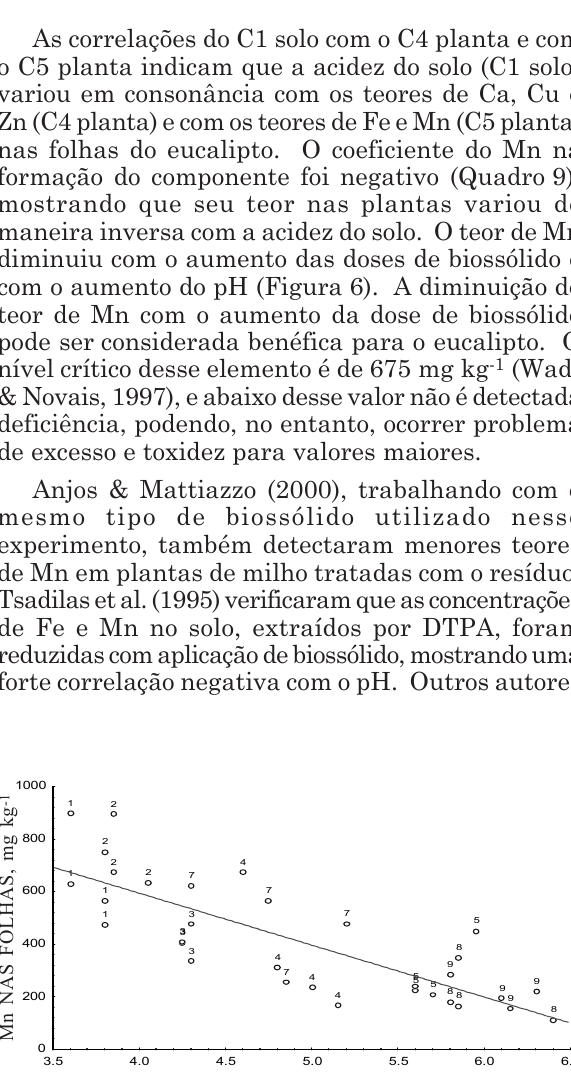
pH DA TERRA Figura 6. Correlação entre os valores de pH da terra e os teores de Mn nas folhas das plantas de eucalipto (r = 0,81 e p < 0,001). Os números sobre as observações identificam o tratamento.